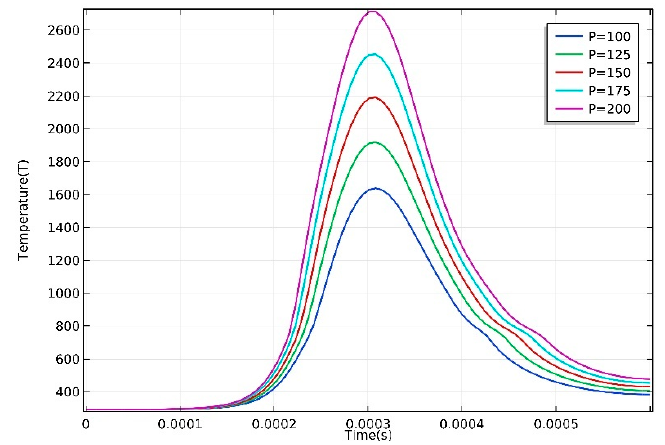
Figure 5. Temperature along the scan path.